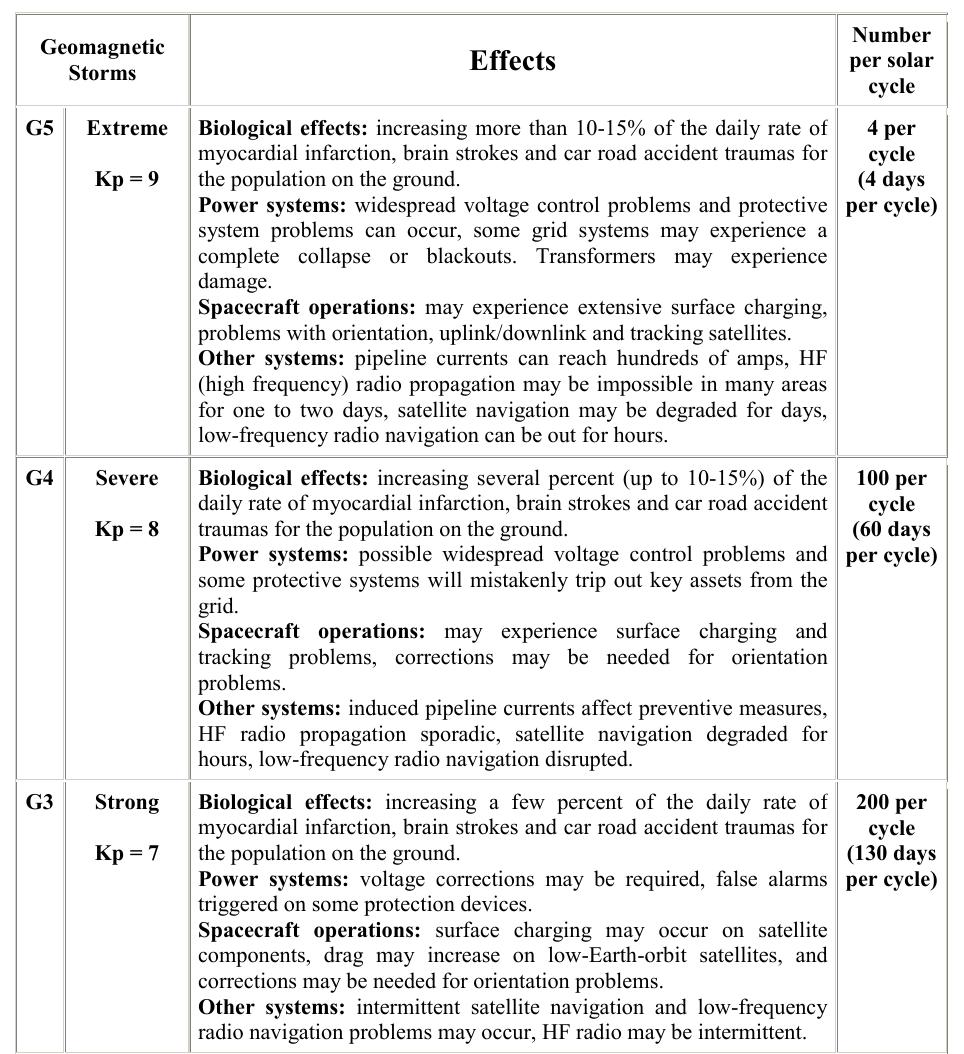
Table 1. The extended NOAA scale of geomagnetic storms influence on people health, power systems, on spacecraft operations, and on other systems (greatest three types, mostly accompanied with Forbush- decreases); in the original NOAA scale we include biological effects according to results discussed above.